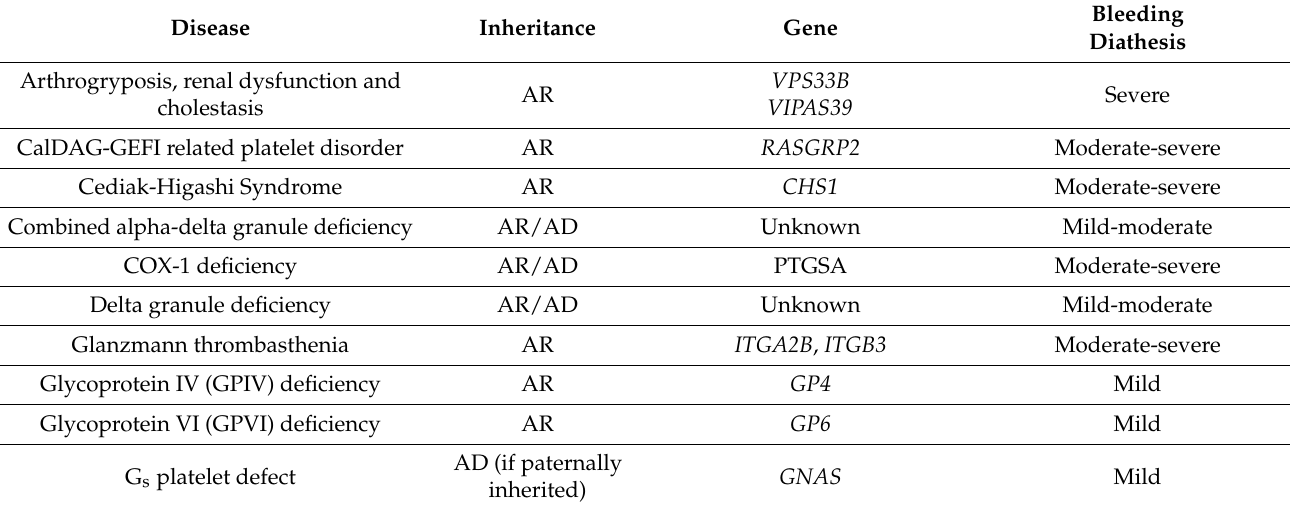
Table 2. Inherited platelet function disorders: disorders in which platelet dysfunction is the dominant phenotypic feature independent of platelet